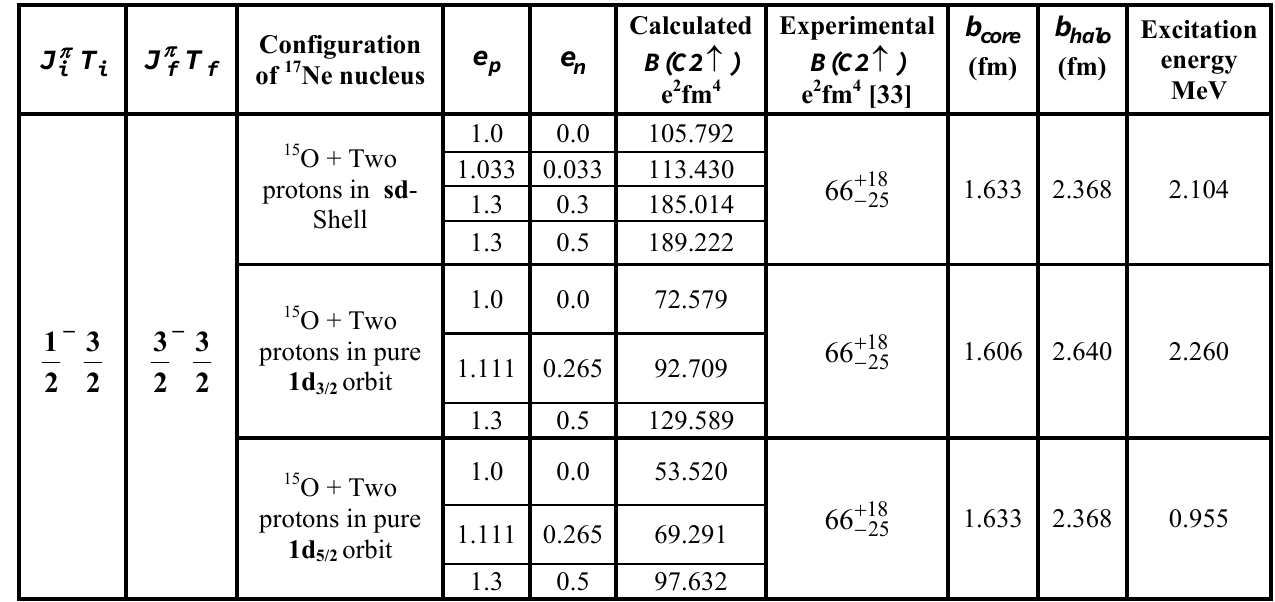
Table 1: The calculated and experimental electric transition strengths of the excited state (